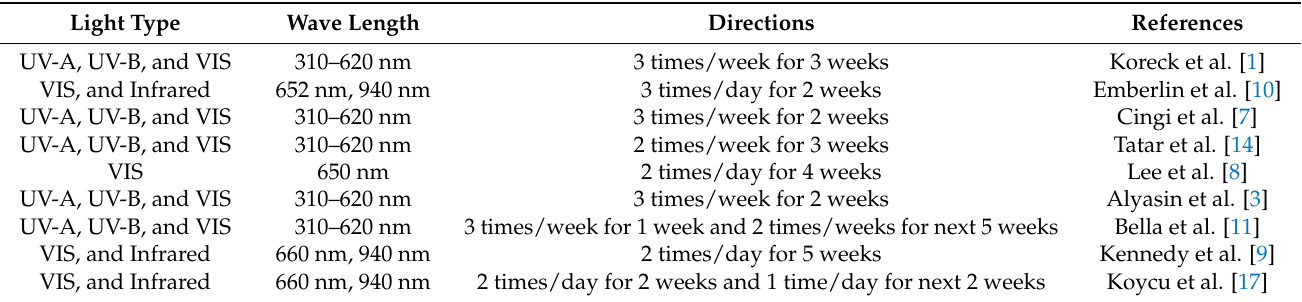
Table 1. Direction and wavelength of